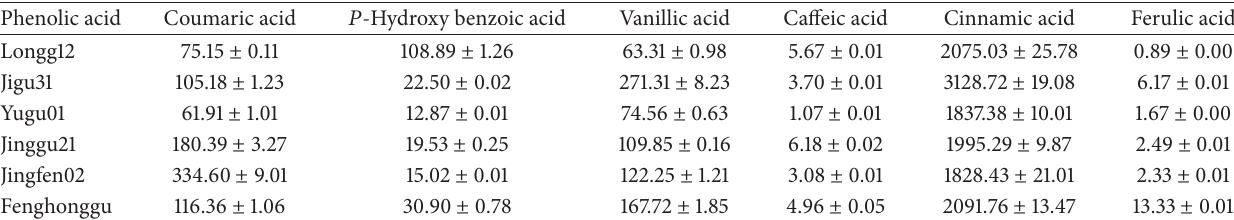
Table 1: Phenolic acid composition of 6 cultivars of whole foxtail